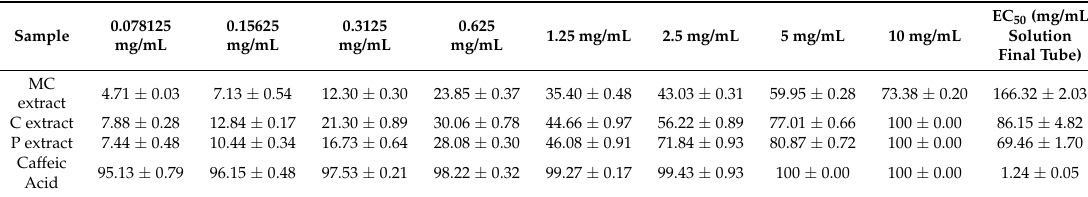
Table 5. Lipoxygenase inhibition activity of selected extracts.